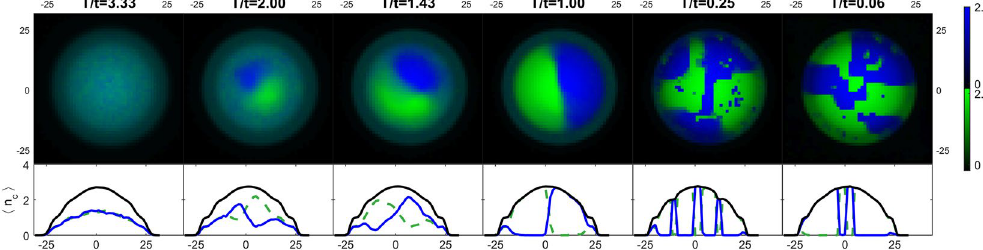
Figure 5. Density maps (first row) and density profiles (second row) of species A (green) and B (blue), for decreasing temperature (left to right) in the SI regime: U / t = 20, U ab / t = 24 and trapping potential strength = 0.12. Density profiles 〈 n ω H / t c 〉 are computed along the horizontal axis through the center of the trap. The total density profile is also shown (black-solid